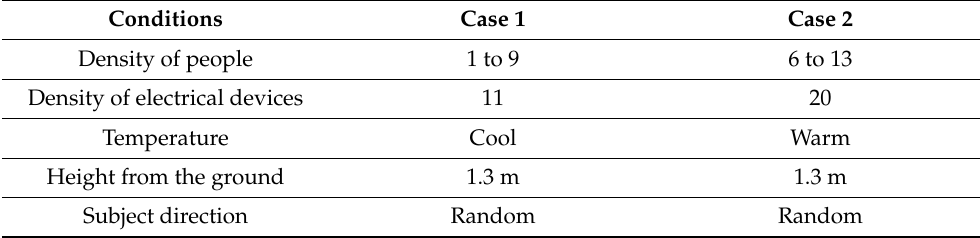
Table 4. The difference in environmental conditions in Case 1 and Case 2.